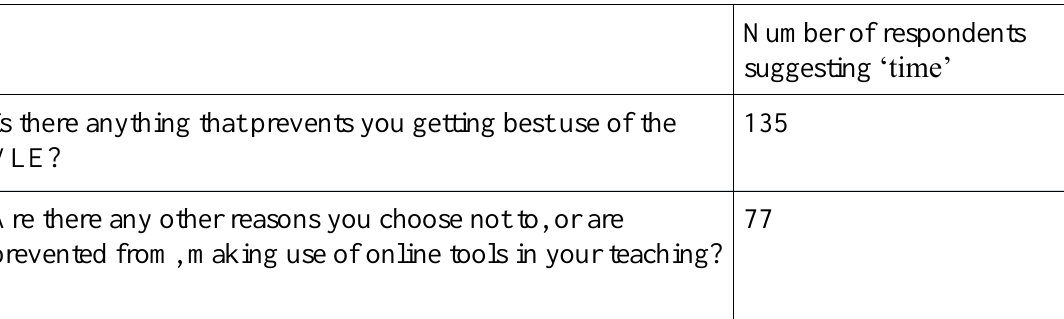
Number of respondents suggesting ‘time’